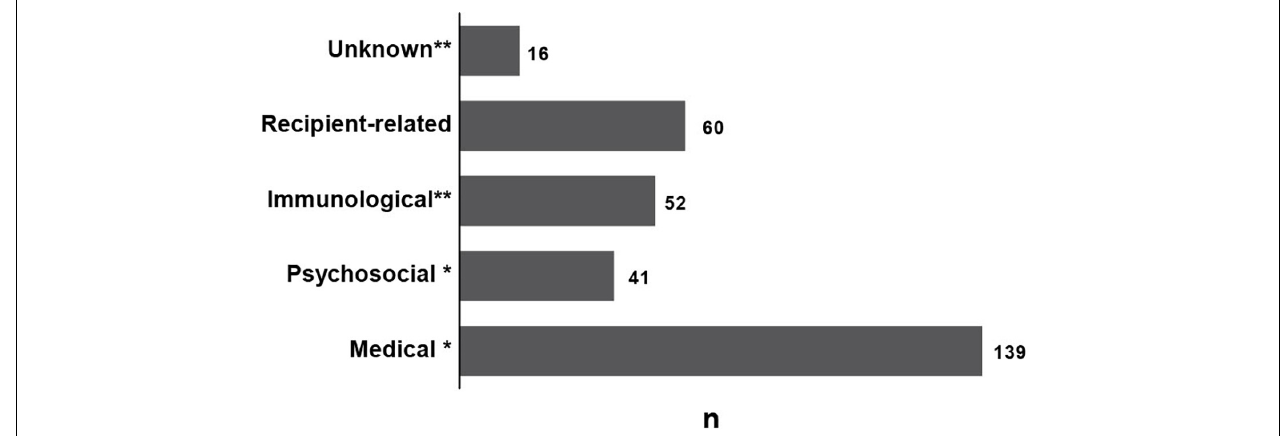
FIGURE 4 | Reasons for disqualification of the potential donor-recipient pairs from the LKD program: n: number. *Donor-related contraindications. **Donor- and/or recipient-related contraindications.